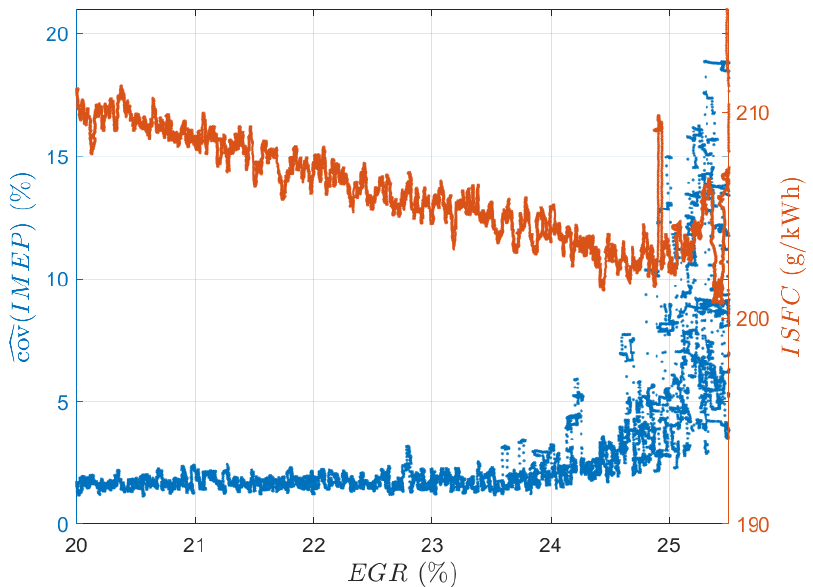
Figure 1. Evolution of the Indicated Specific Fuel Consumption ( ISFC ) and of the estimated engine stability cov ( IMEP ) , function of EGR rate. (cid:100)